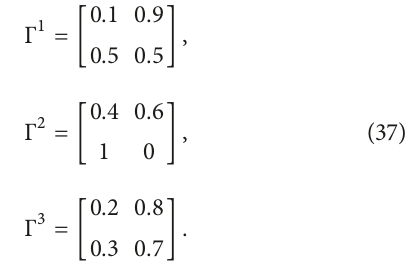
Figure 6: 𝐸(𝑥 T 𝑘 𝑅𝑥 𝑘 ) of the closed-loop system for Example